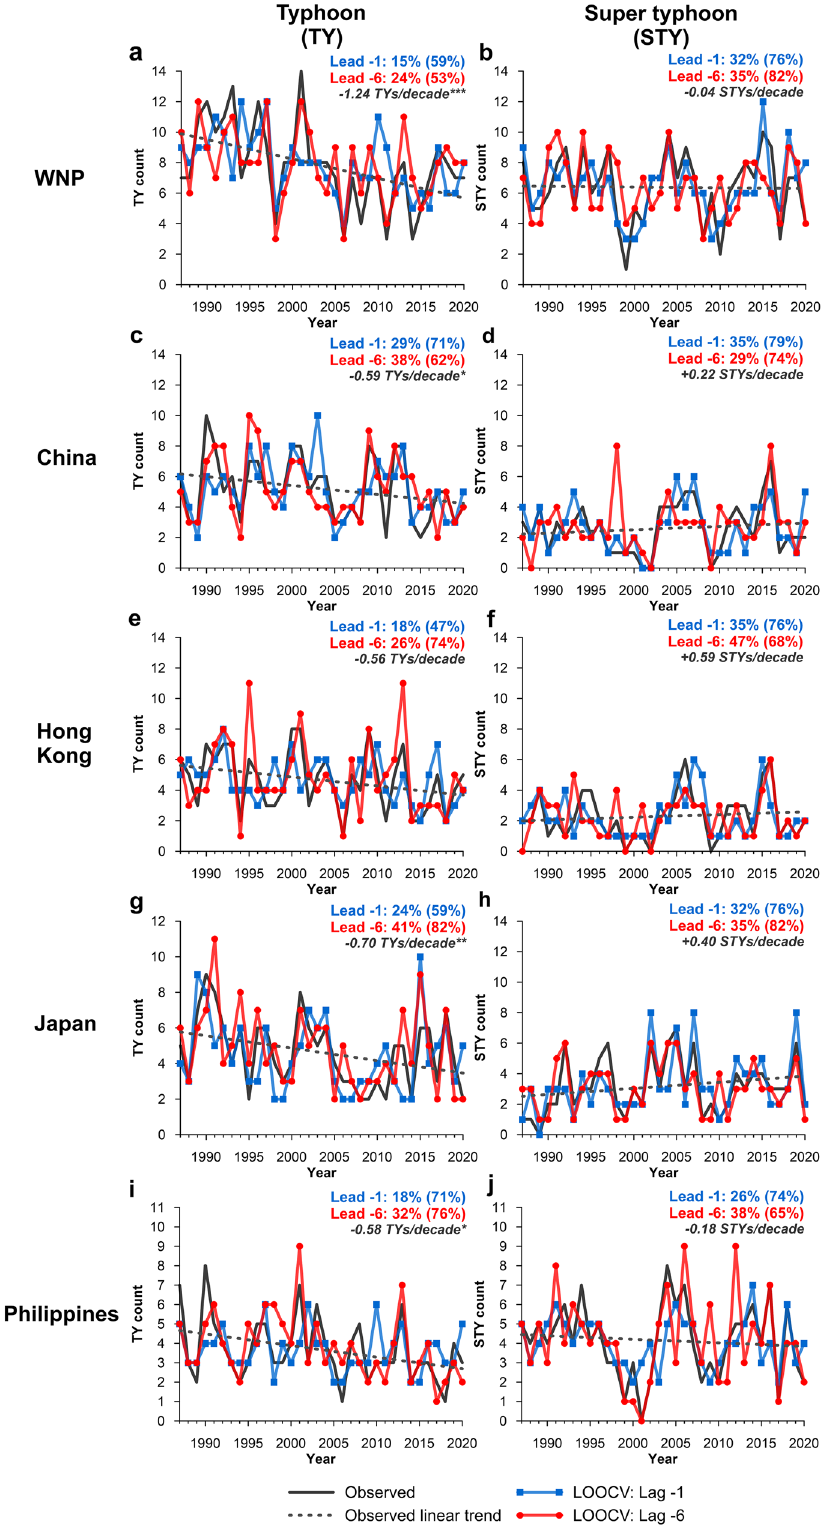
Figure 4. Comparison of observed and LOOCV predicted TYs (left column) and STYs (right column) for the WNP ( a , b ), China ( c , d ), Hong Kong ( e , f ), Japan ( g , h ) and the Philippines ( i , j ) between 1987 and 2020. The LOOCV prediction is compared for two pre-season periods: lead − 1 (1 month before the start of the typhoon season; blue line) and lead − 6 (6 months before the start of the typhoon season; red line). On-panel percentage values indicate LOOCV SR-E (SR ± 1 in parentheses) for models lead − 1 and lead − 6. Dashed line represents observed linear trend with on-panel trend (/decade) summarised in grey italics with statistical significance (Mann–Kendall test) denoted by an asterisk (*significant at 90% confidence level; **significant at 95% confidence level; ***significant at 99% confidence